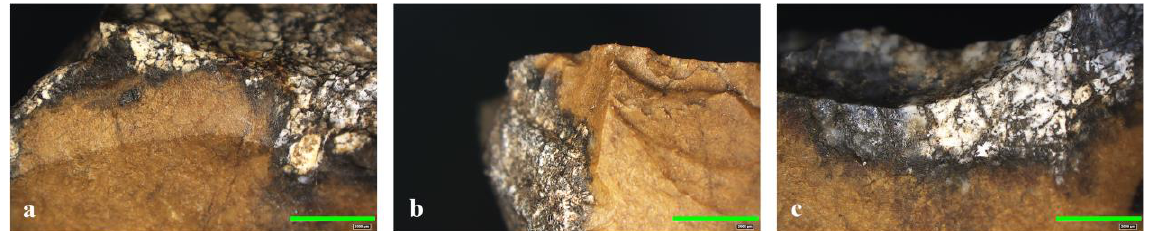
Figure 20. Lojanik 1, Cluster 1, sample 5, fragment of the raw material, scale bar equal to 2000 μm